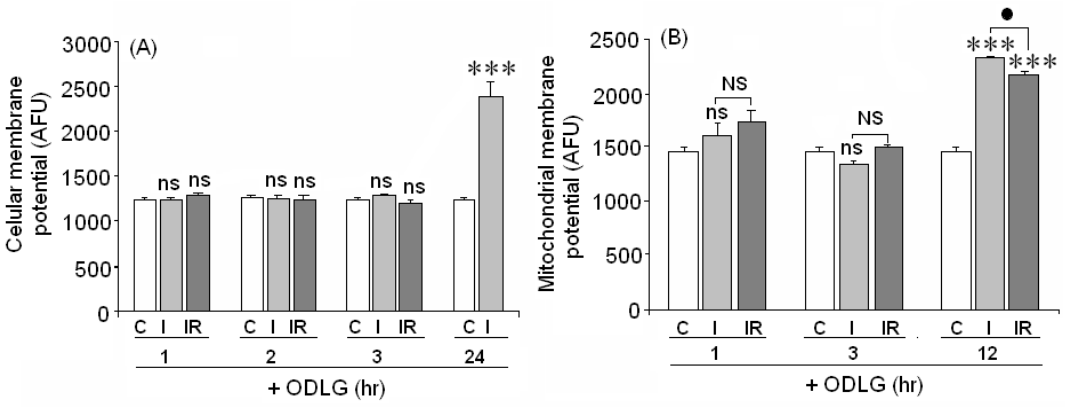
Figure 8. ( A ) Effect of 1, 2, 3 and 24 h of ODLG exposure on cell membrane potential; ( B ) Effect of ODLG on cell mitochondrial membrane potential at different ODLG exposure time. Results are means ± SEM of two experiments with cells from different cultures, each one performed in triplicate with different batches of cells (6 measurements/condition). ns = not significant ( vs. control); NS = no significant ( vs. I and IR); ( • )= p < 0.05 ( vs. I and IR) and (***)= p < 0.005 ( vs.